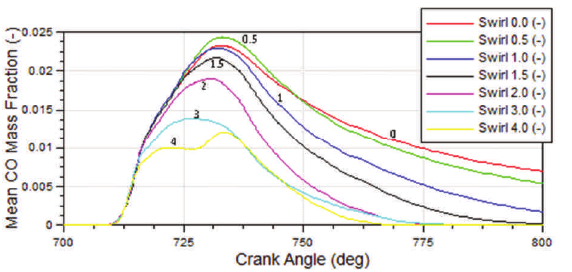
Fig. 11. Mean CO mass fraction against crank angle position for different swirl